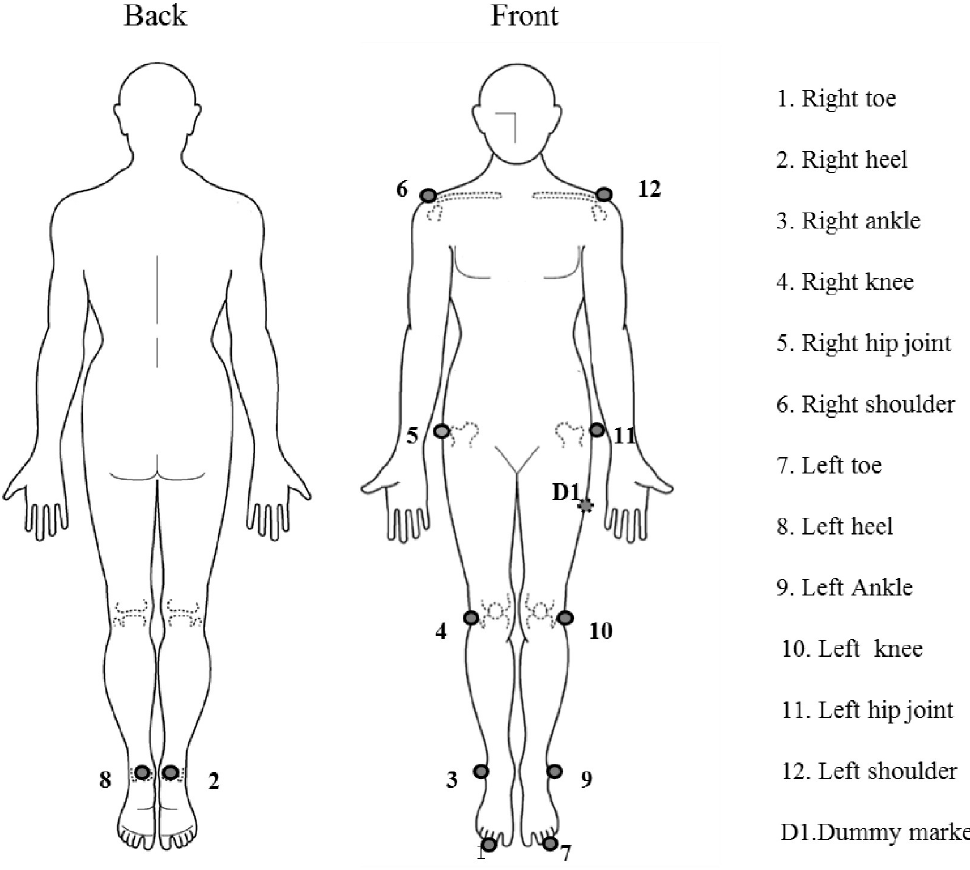
Fig 1. Reflection marker